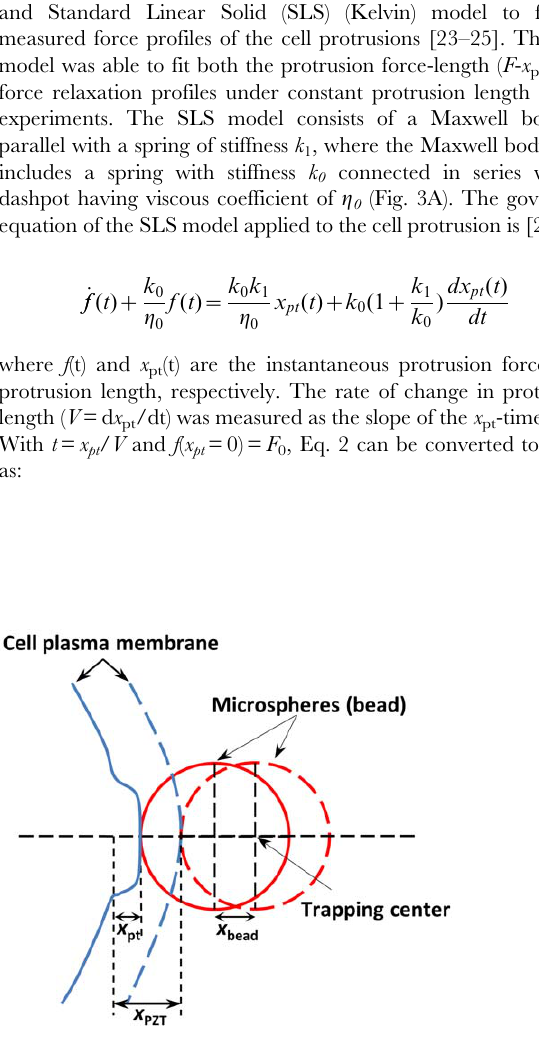
Figure 2. Schematic of bead-cell contact system. Dashed lines show initial cell-bead contact where there is no external force applied on the bead. Solid lines show the bead-cell system once the cell is moved away from the trapped bead by distance x pzt . Bead is displaced from the trapping center by x bead and the length of the protrusion is x pt .